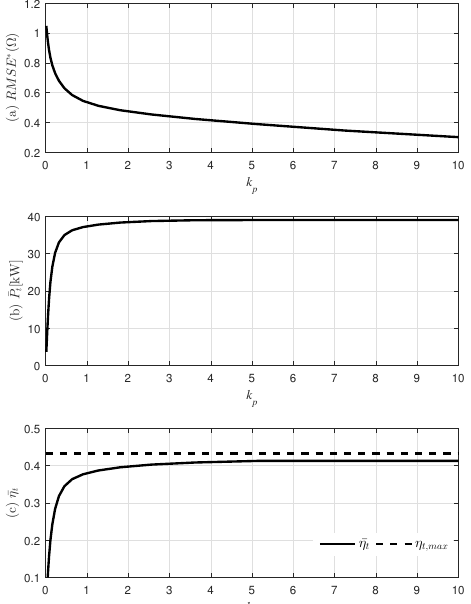
Figure 5. Simulation result of the first 30 s with the i-MET controller when k p = 10 : ( a ) wave λ and water column positions x ; ( b ) airflow speed at the turbine duct V x and pressure drop across the turbine ∆ p Ω and its desired value Ω t ; ( c ) turbine rotor angular velocity d ; ( d ) generator damping coefficient (control input) b g and power extraction from the turbine P t ; ( e ) turbine efficiency η t and its maximum value η t , max .